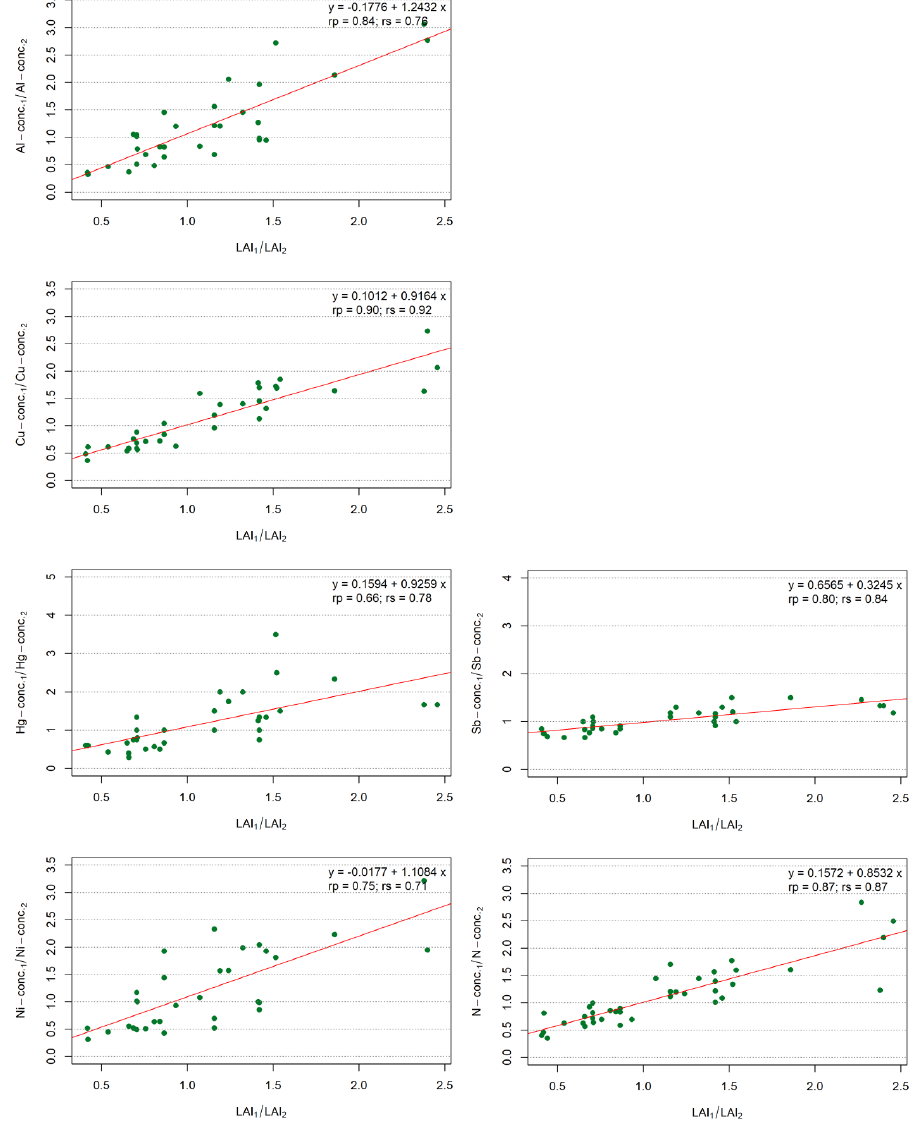
Figure 3. Regression models for the relationships between the ratio of concentrations of Al, Cu, Hg, Ni, Sb, and N in the mosses and the ratio of leaf area indices at neighboring canopy drip and open land plots.